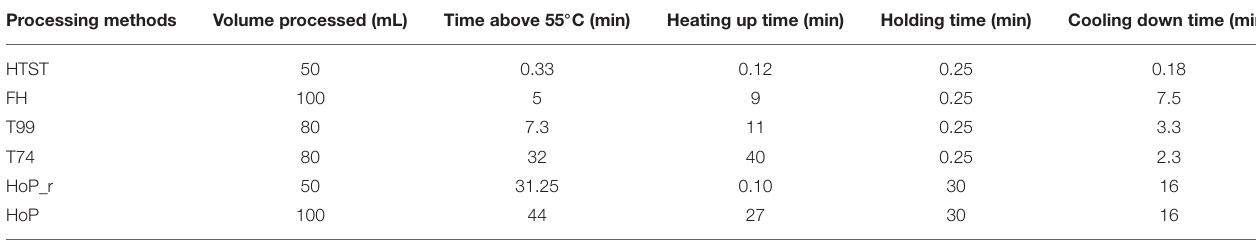
TABLE 1 | Time-temperature profiles of the six processing methods. Processing methods